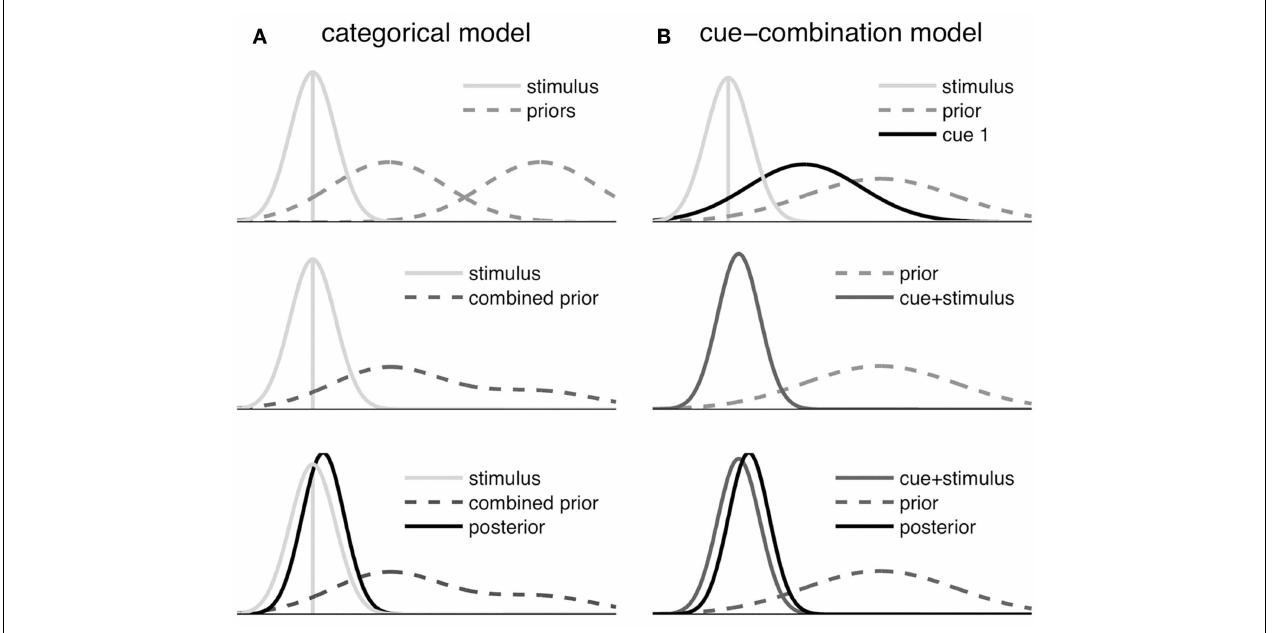
symbolic cue.Then the resulting Gaussian mixture distribution (combined prior) is fused with the stimulus measurement to derive the posterior. (B) Cue-combination model: first the stimulus likelihood and the likelihood corresponding to the current symbolic cue signal are fused.Then this fused signal (cue + stimulus) is combined with the prior, yielding the